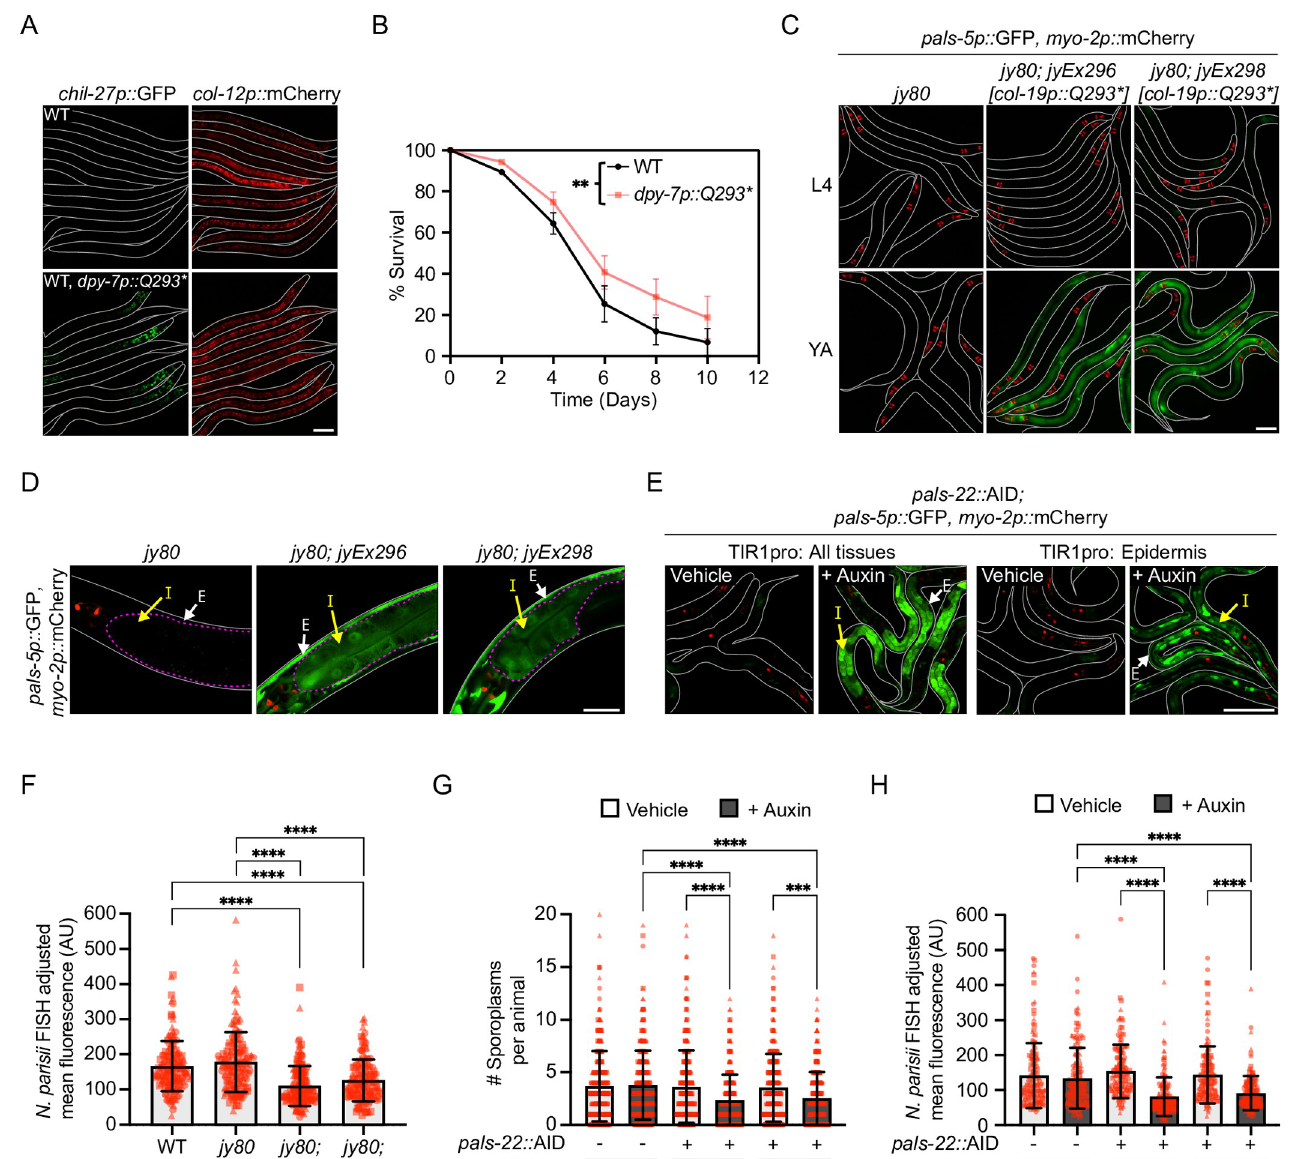
Fig 6. A PALS-22/25-mediated immune response in the epidermis triggers protective immunity in the epidermis and intestine. A) Epidermal ( dpy-7p )- specific expression of pals-25(Q293 � ) leads to constitutive expression of chil-27p ::GFP. col-12p ::mCherry is part of the same transgene and is constitutively expressed starting from the L4 stage. L4 animals are shown with lines denoting the outline of the body. Scale bar = 100 μ m. B) dpy-7p :: pals-25(Q293 � ) animals have increased survival upon infection with M . humicola as compared to WT animals at 20˚C. �� p < 0.01, Log-rank test. n = 270 animals per genotype, 90 animals per replicate across three experimental replicates. C) Adult-specific expression of pals-25(Q293 � ) in the epidermis induces pals-5p ::GFP expression. Staged L4 and young adult (YA) animals are shown for each genotype. Scale bar = 100 μ m. D) Higher magnification imaging shows that epidermis-specific expression of pals-25(Q293 � ) in young adults induces pals-5p ::GFP expression in both the epidermis (white arrows ‘E’) and intestine (yellow arrows ‘I’). Scale bar = 20 μ m. Exposure time was set to optimize intestinal pals-5p ::GFP expression (dashed magenta lines). E) Auxin-mediated depletion of PALS-22 in all tissues, or specifically in the epidermis, induces pals-5p ::GFP expression in both the epidermis (white arrows ‘E’) and intestine (yellow arrows ‘I’). L1 animals treated with either auxin or vehicle control for 24 h at 20˚C are shown. Scale bar = 50 μ m. F) Epidermis-specific expression of pals-25(Q293 � ) results in increased resistance to N . parisii at 30 hpi of young adult animals compared to both WT and a pals-22 pals-25(jy80) background without the pals-25(Q293 � ) transgene. Kruskal-Wallis test with Dunn’s multiple comparisons test. n = 150 animals per genotype, three experimental replicates. Symbols represent N . parisii FISH fluorescence signal normalized to body area for individual worms; head regions excluded because of expression of the myo-2p ::mCherry co-injection marker. G-H) Auxin-mediated depletion of PALS-22 in all tissues, or specifically in the epidermis, increases resistance to N . parisii at 3 hpi (G) or 30 hpi (H) when compared to vehicle control. Two-way ANOVA with Sidak’s multiple comparisons test. 3 hpi: n = 300 animals per genotype, three experimental replicates. Symbols represent the number of N . parisii sporoplasms that infected an individual animal, as determined by N . parisii -specific fluorescent FISH